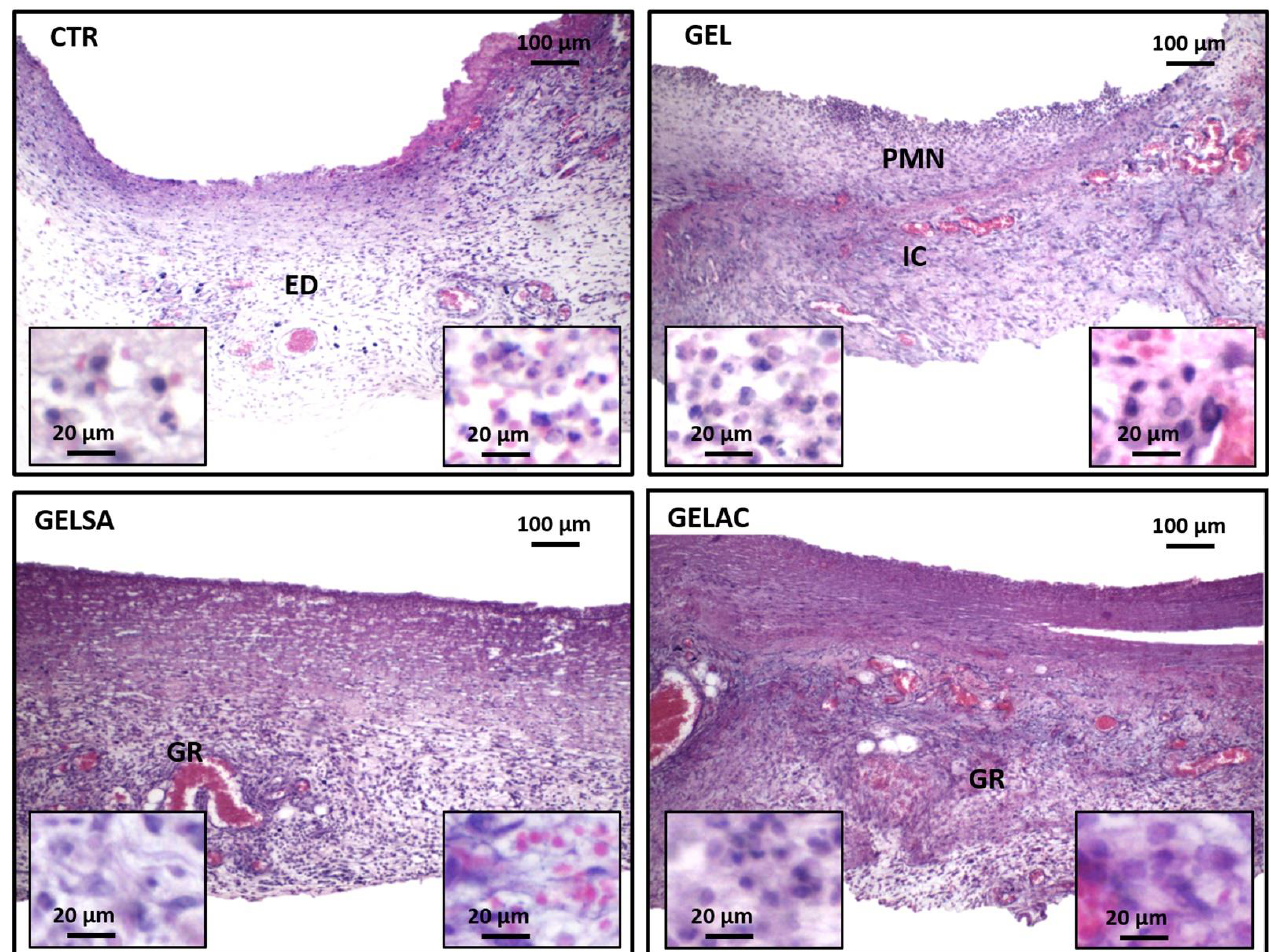
Figure 11. Photomicrographs of HE-stained histological sections representative of the 3-day repair process. CTR shows inflammatory infiltration rich in polymorphonuclear neutrophils associated with intense interstitial edema (100×); highlighted the presence of neutrophil polymorphonuclear leukocytes (small lobulated nuclei) and lymphocytes (dark round nuclei) (400× and 800×). GEL and GELSA present edema and infiltrate of superficial polymorphonuclear neutrophils and a very immature granulation reaction at the base of the wound (100×), while GELAC presents greater fusocellular cellularity of the granulation reaction; highlighted, in the three groups, stromal spindle cells that make up the granulation reaction (400× and 800×). Caption: CTR — control group; GEL — group